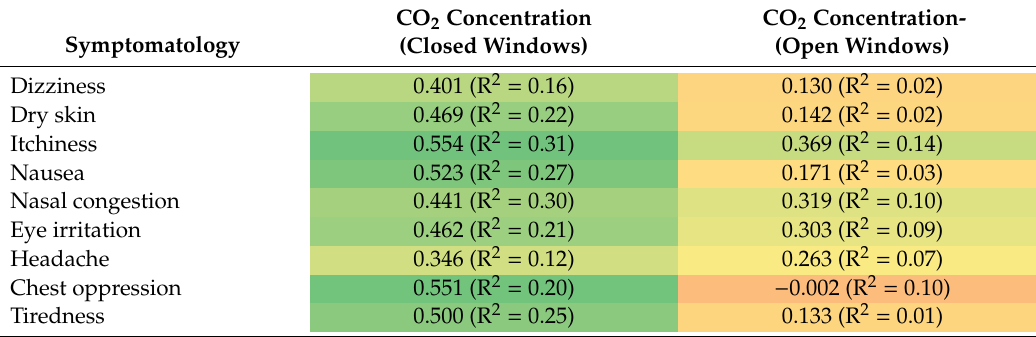
Table 8. Correlations between CO 2 concentration and student